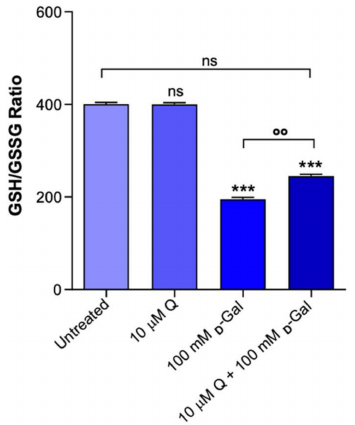
Figure 7. Intracellular GSH/GSSG ratio measured in erythrocytes left untreated or incubated for 24 h with 100 mM D -Gal with or without pre-treatment with 10 µ M Q or 10 µ M Q alone. ns, not statistically significant versus untreated; ***, p < 0.001 versus untreated (control); ◦◦ , p < 0.01 versus 100 mM D -Gal, one-way ANOVA followed by Bonferroni’s multiple comparison post hoc test ( n =